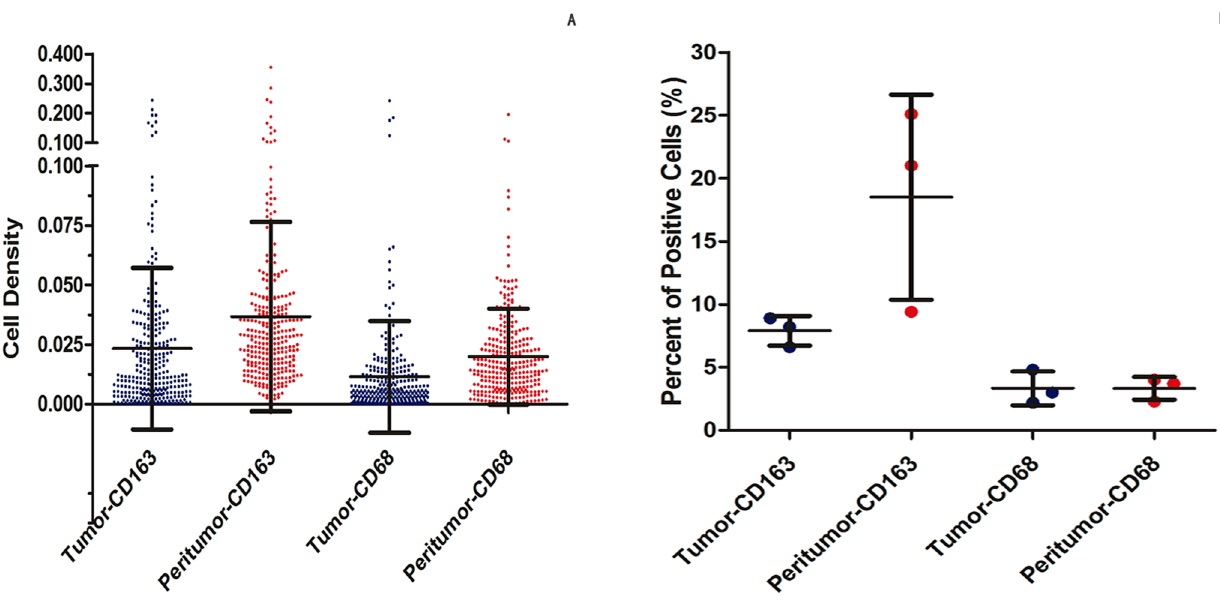
Figure 2. The dot plots of the densities of CD163 + and CD68 + cells in tumor and in peritumoral liver tissue from the 295 patients (cohort 1). (A) The dot plots of ratios of CD163 and CD68-expressing cells to total cells in 3 paired tumors and peritumoral liver tissues which were counted by flow cytometry (B). Error bars, S.D.